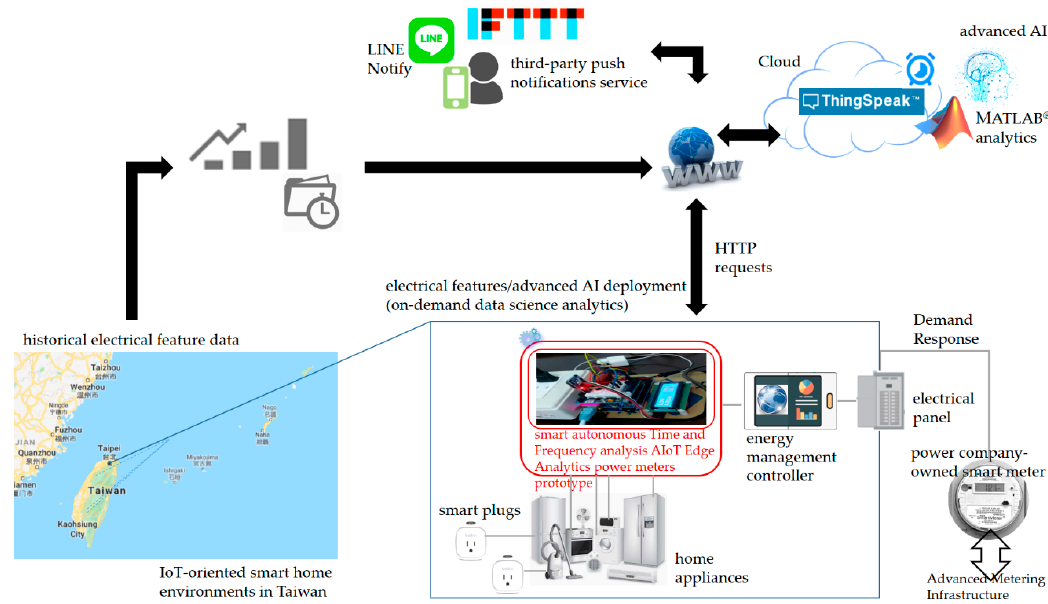
Figure 3. Launched edge analytics-based artificial intelligence across Internet of Things (AIoT) with open and powerful cloud analytics configured to collaborate with the developed smart autonomous time and frequency analysis current sensor-based power meter prototype as edge analytics over fog-cloud analytics for DSM in a smart grid in this study.